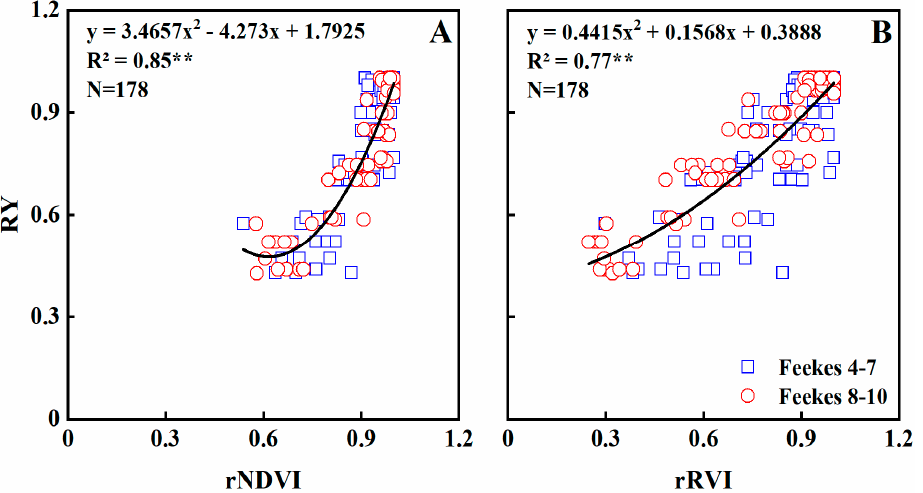
Figure 10. Quantitative relationships of rNDVI ( A ) and rRVI ( B ) to RY in wheat varieties under varied N rates across all growth stages.